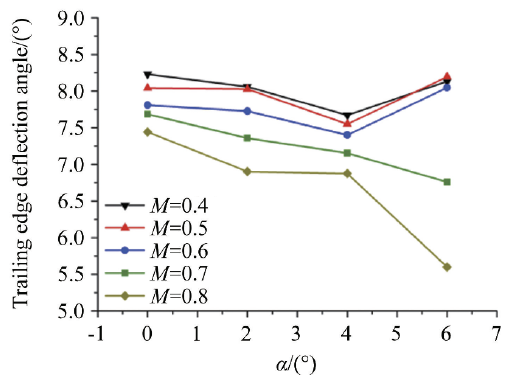
Figure 15. Maximum trailing edge deflection angle under different Mach numbers and angles of attack (middle section).